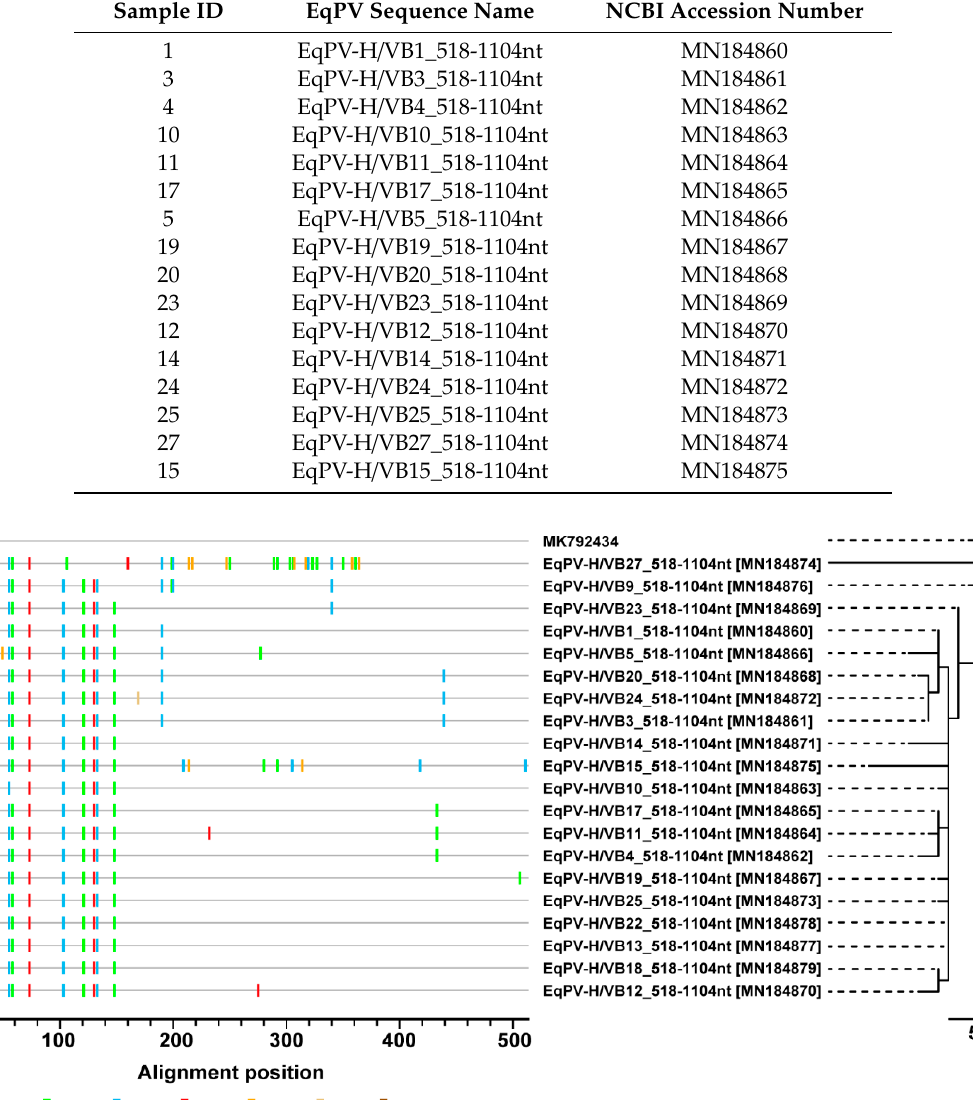
Figure 4. Highlighter plot displaying nucleotide exchanges in EqPV NS1 in the screened cohort compared to a previously published strain from Europe (MK792434). Labelling of nucleotides according to the International Union of Pure and Applied Chemistry (IUPAC) code. Length of bar scale of neighbour-joining tree indicating number of nucleotide exchanges. The input multiple sequence alignment was created with Mega X.